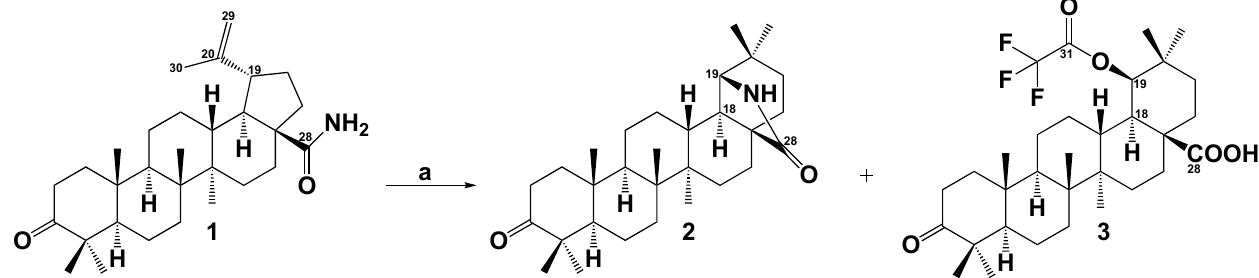
Scheme 1 . Synthesis of compounds 2 and 3 by the reaction of betulonic amide with trifluoroacetic acid. Reagent and condition: a. TFA, CHCl 3 , ∆ , 1 h.